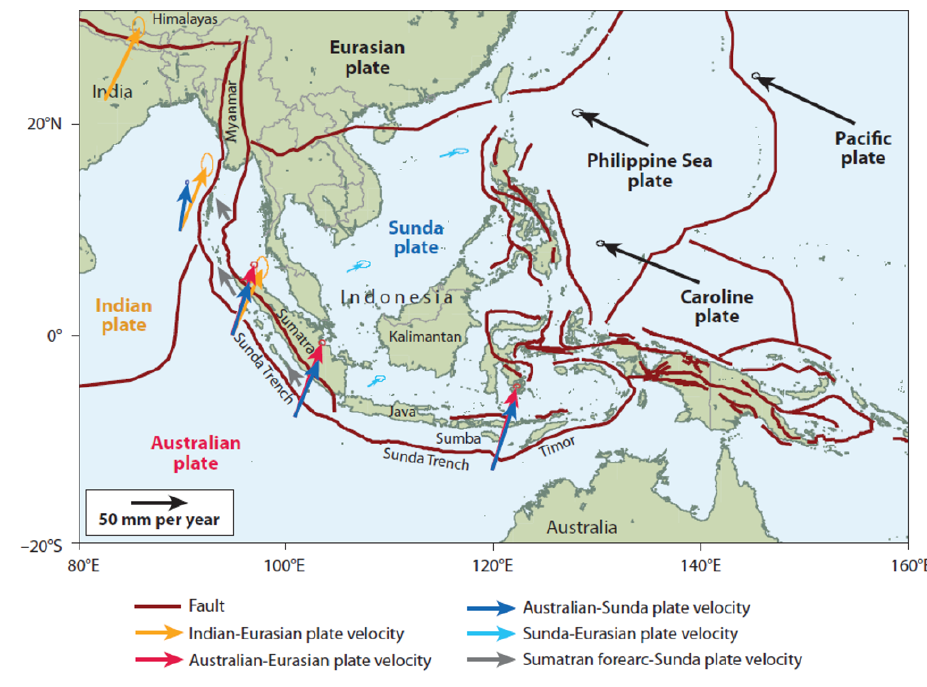
Table 1: GDACS and TSUNAMI alert levels 1